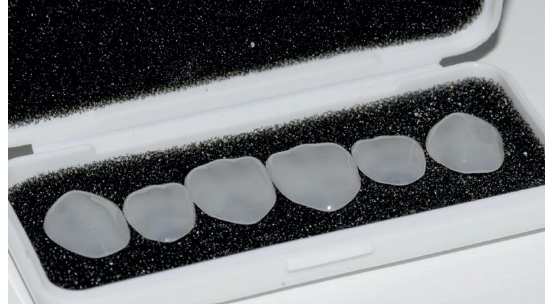
Figure 4. Prefabricated laser-sintered veneers.